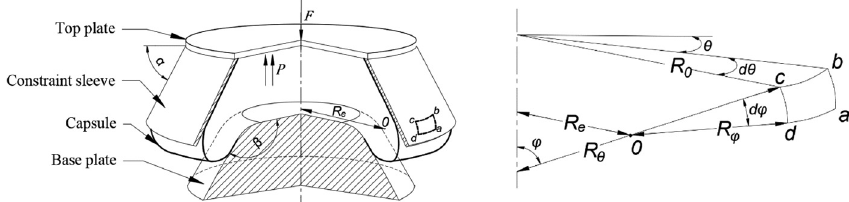
Figure 1: Schematic diagram of the air spring